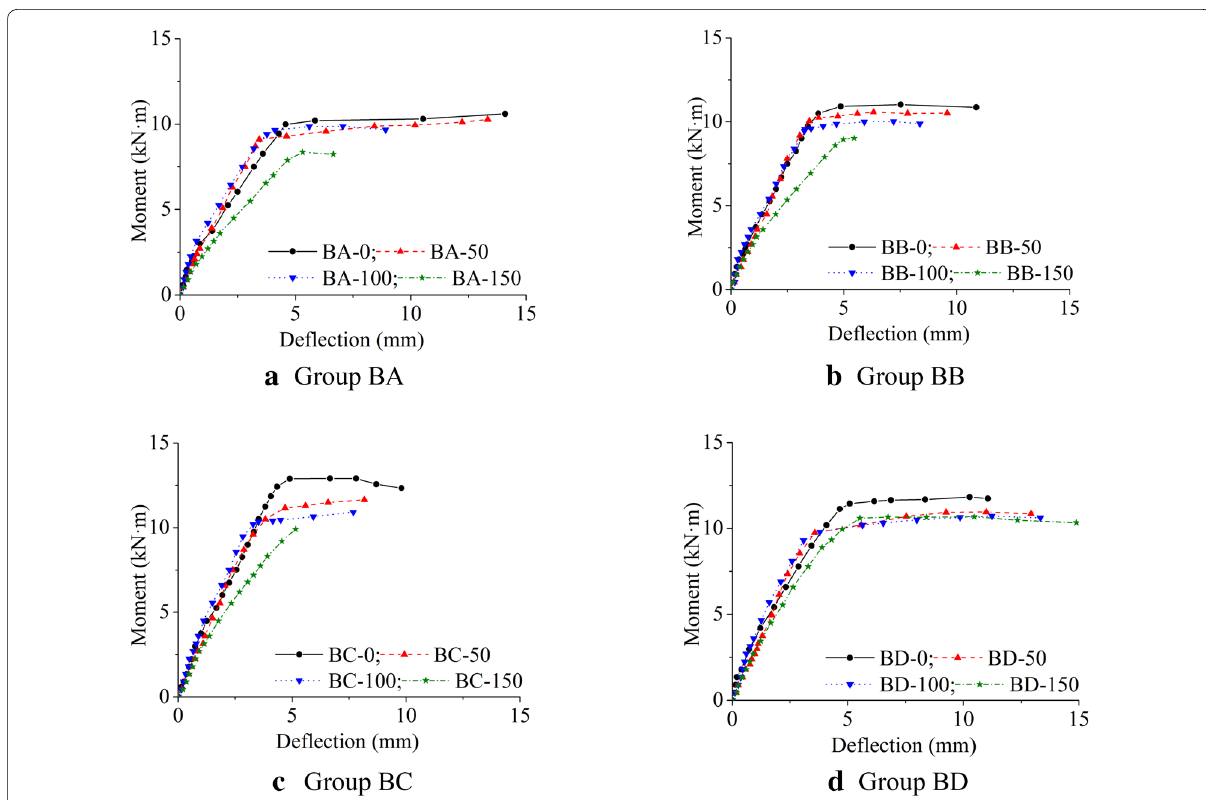
Fig. 5 Effect of freeze–thaw cycles on moment-deflection curves.